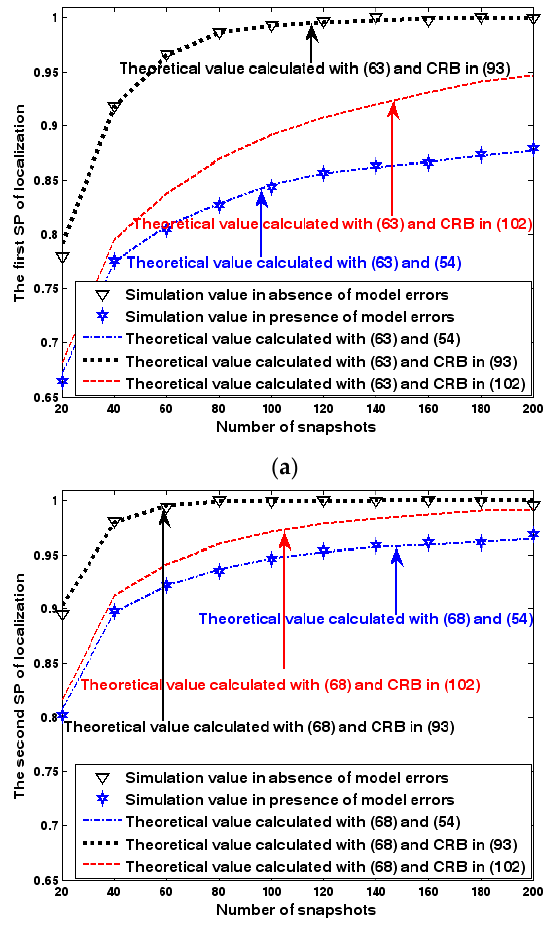
Figure 15. SP of localization versus number of snapshots. ( a ) The first SP of localization versus number of snapshots. ( b ) The second SP of localization versus number of snapshots.